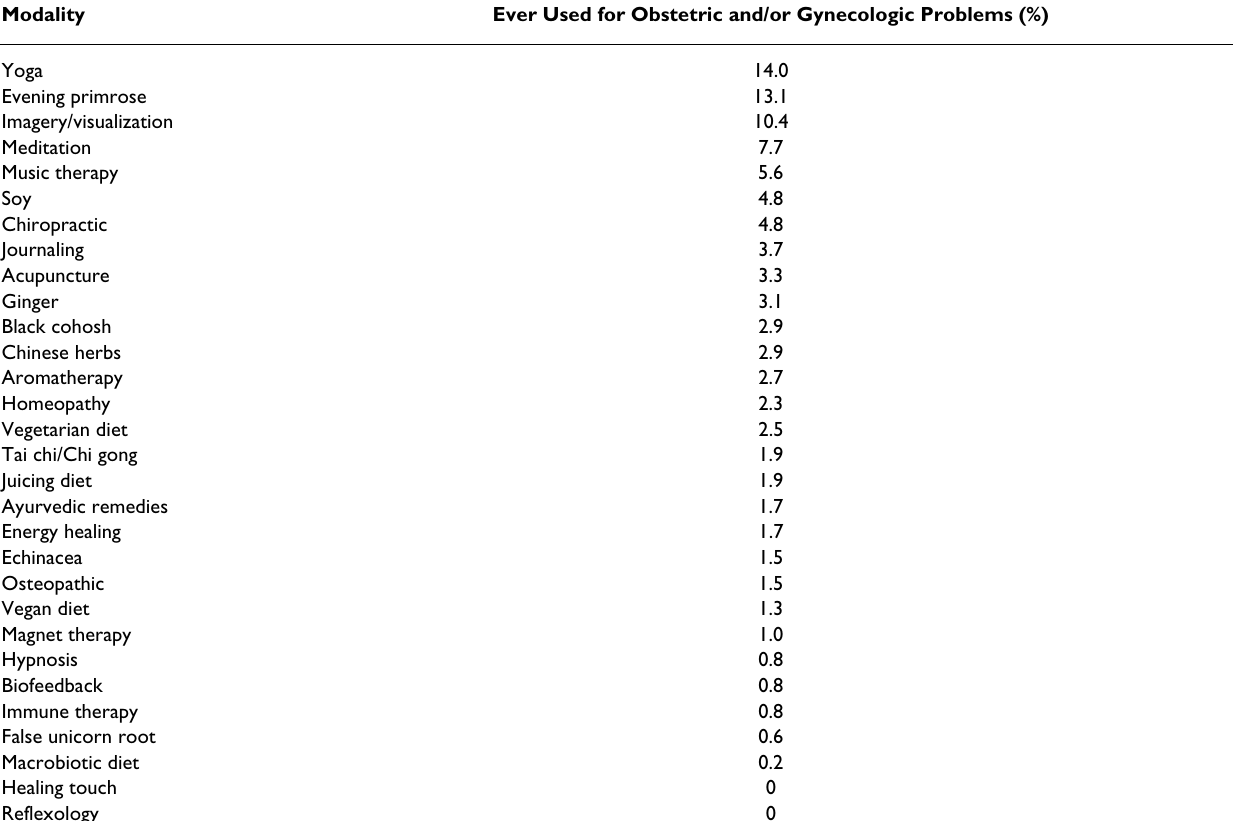
Table 4: Patients' ever use of CAM modalities for obstetric and/or gynecologic problems Modality Ever Used for Obstetric and/or Gynecologic Problems (%) Yoga 14.0 Evening primrose